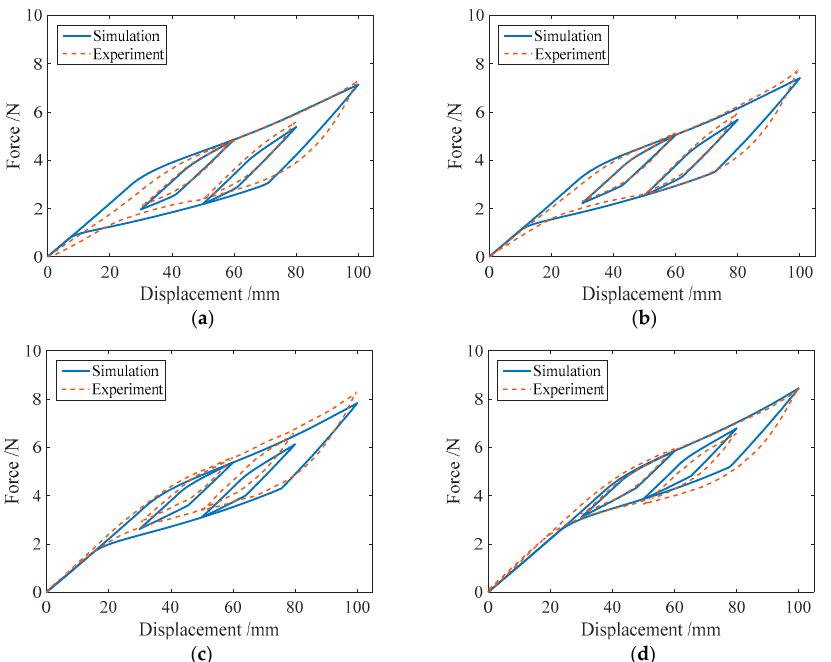
Figure 16. The simulation results of the force-displacement relationship of specimen SMA-S2 at different temperatures: ( a ) 22 ℃ ; ( b ) 25 ℃ ; ( c ) 30 ℃ ; ( d ) 40 ℃ .